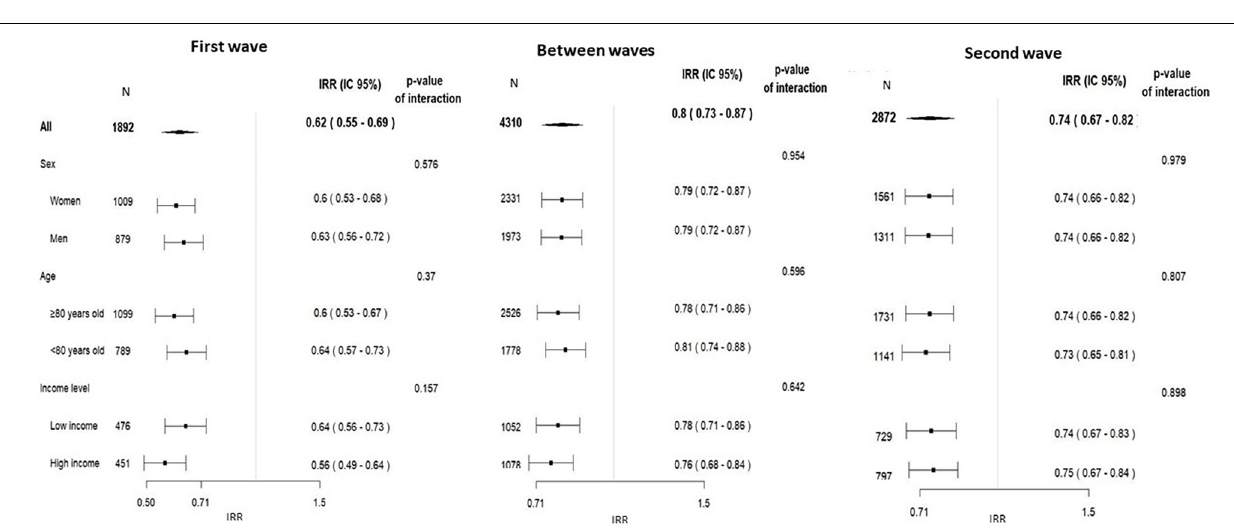
FIGURE 4 | Incidence rate ratios of acute heart failure admissions, in the three predefined pandemic period vs. the corresponding pre-pandemic period (2019) by subgroups of socioeconomic factors, and the p -value for the interaction between period and each socioeconomic